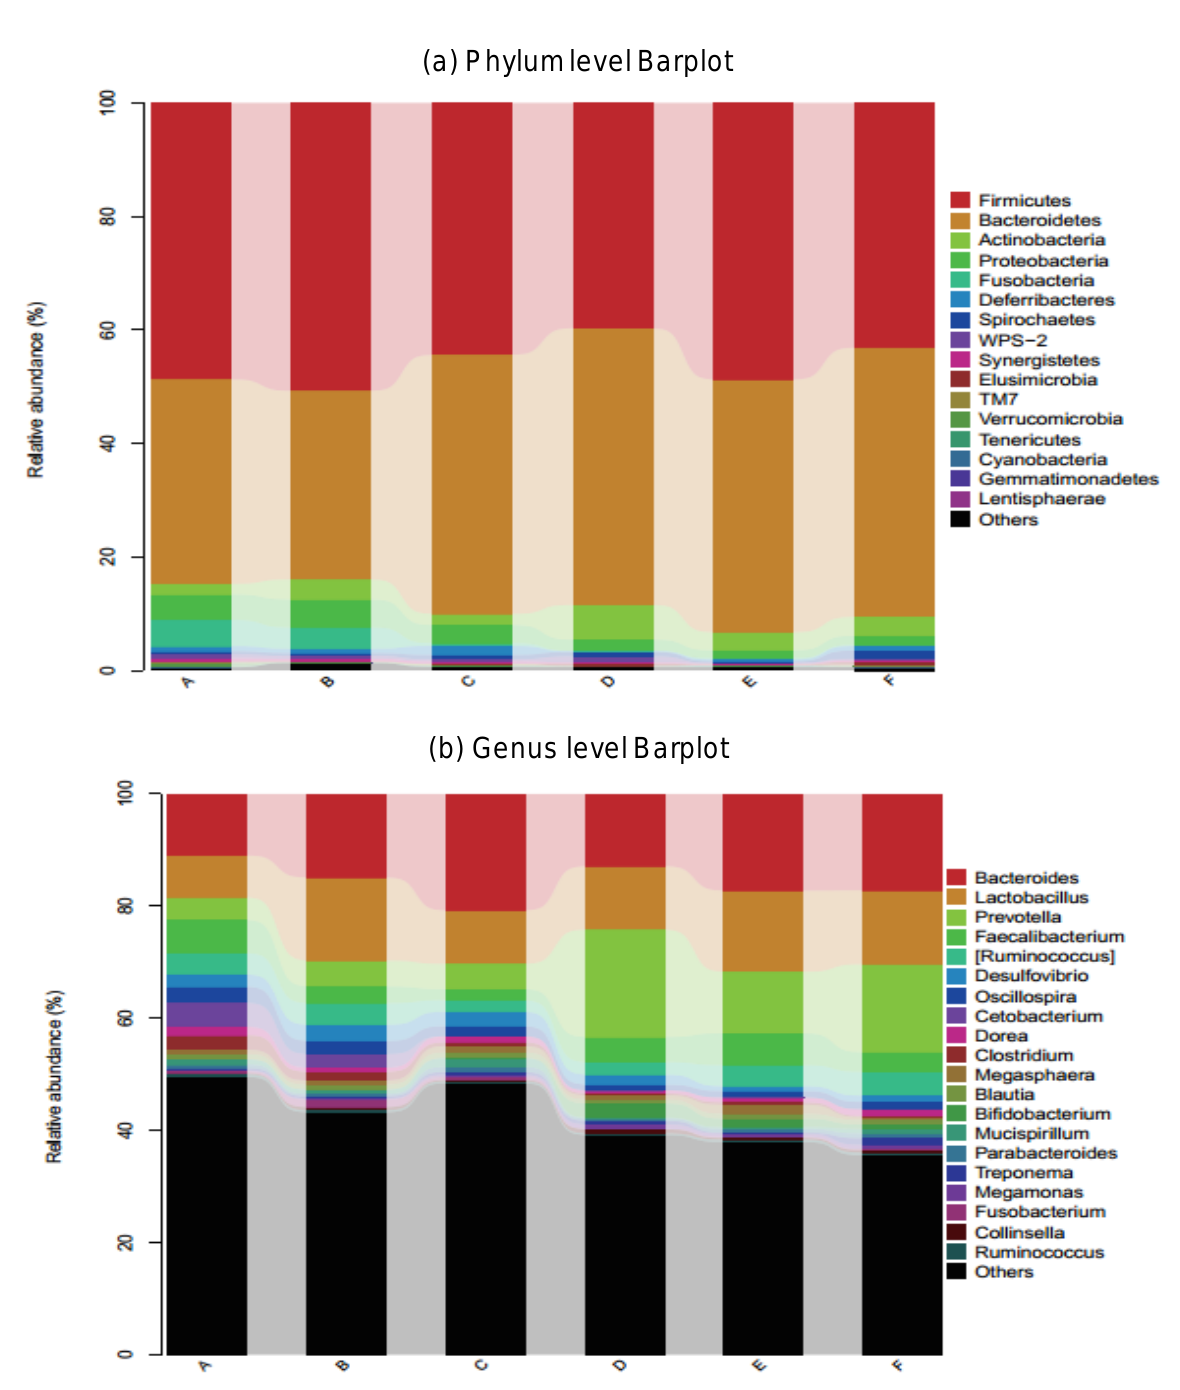
Figure 7. Relative abundance of the dominant bacteria communities in the corn-fed groups (A, B, and C) and the wheat-fed groups (D, E, and F). Each bar chart represents the relative abundance of each group. Each color represents a specific bacteria phylum ( a ) and a specific bacteria genus ( b ).